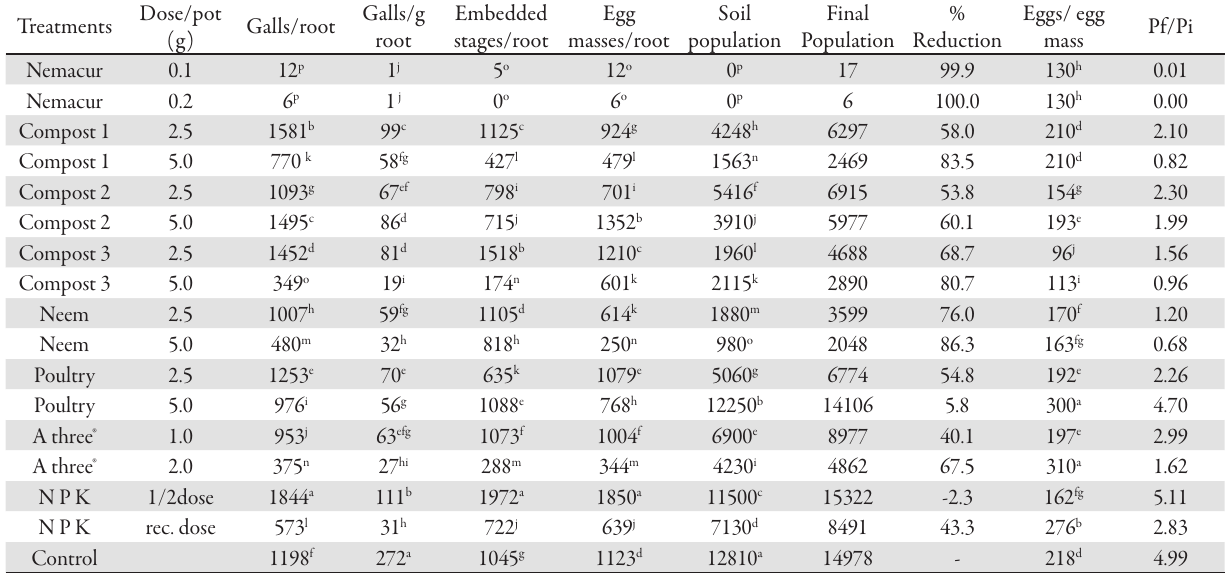
Tab. 2. Reproduction of M. incognita as influenced by organic and inorganic